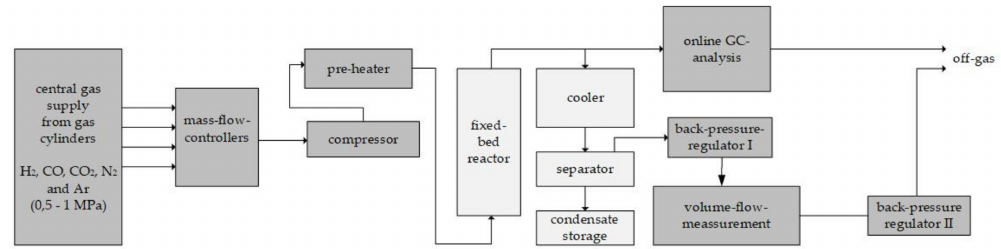
Figure 3. Basic flow scheme of the test setup.